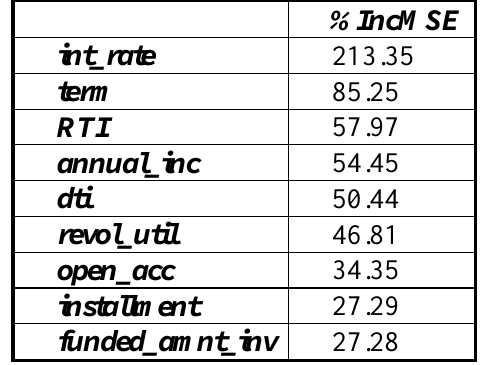
Table 3. Significant features using random forest regression